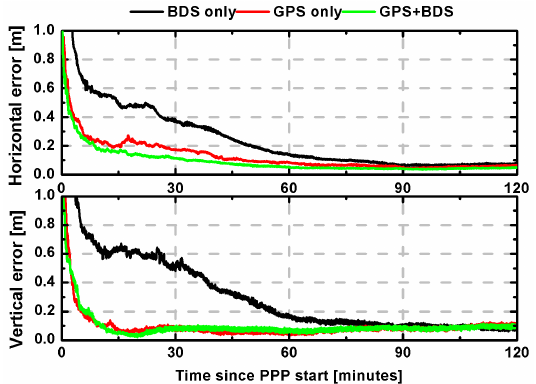
Figure 11. The convergence time of real-time dual-frequency PPP.